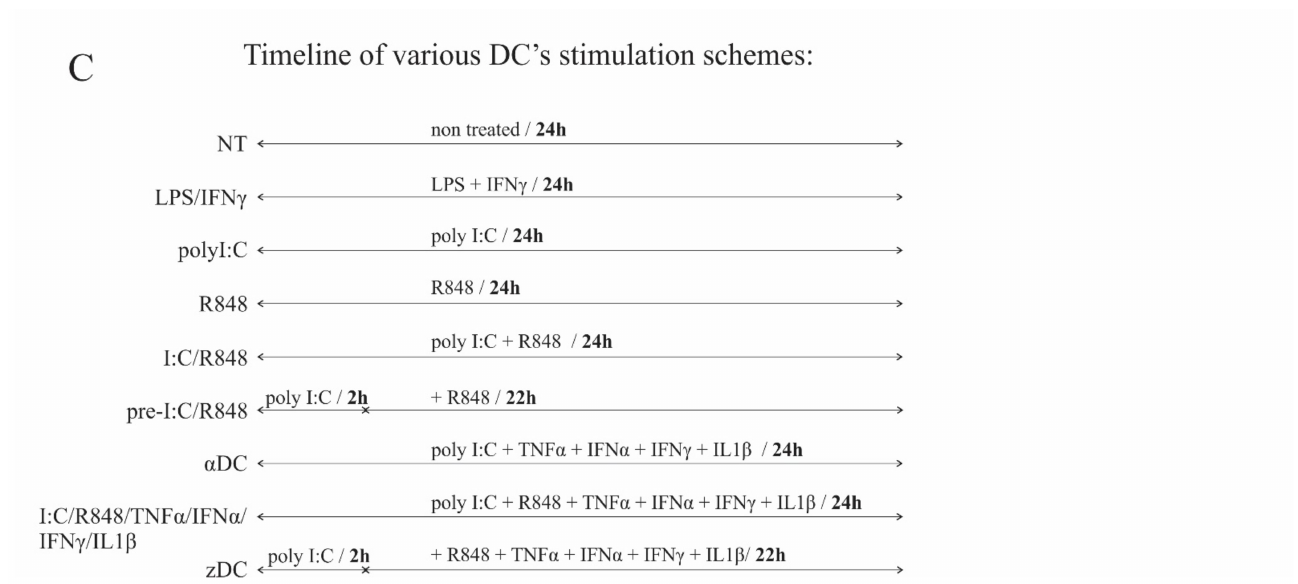
Figure 1. zDCs possess extensive capacity for IL-12p70 production upon CD40-ligand stimulation. Dendritic cells were generated from peripheral blood monocytes, as described in the Materials and Methods. ( A ) The production of IL-12p70 was measured directly from culture supernatants, after 24 h stimulation of DCs using various maturation protocols, as depicted in the figure. ( B ) IL-12p70 was measured from co-cultures after DCs were activated, extensively washed, and re-stimulated via CD40-CD40L pathway. Data represent mean ± SD of seven independent experiments. The black dots represent individual sample values. Statistical significance for comparison of zDC vs. α DC samples was performed using Student’s unpaired t test. A p value of less than 0.05 was considered statistically significant. (** p < 0.01; *** p < 0.001). ( C ) A timeline of various DC’s maturation